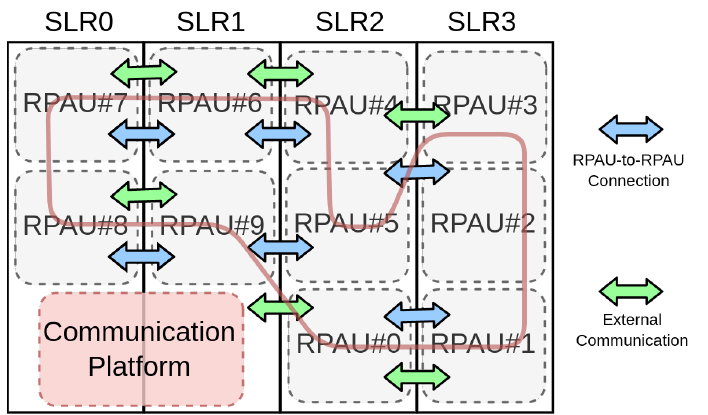
Figure 7: The proposed ’ring’ structured floorplan to minimize routing cost for the implementation with 10 RPAU